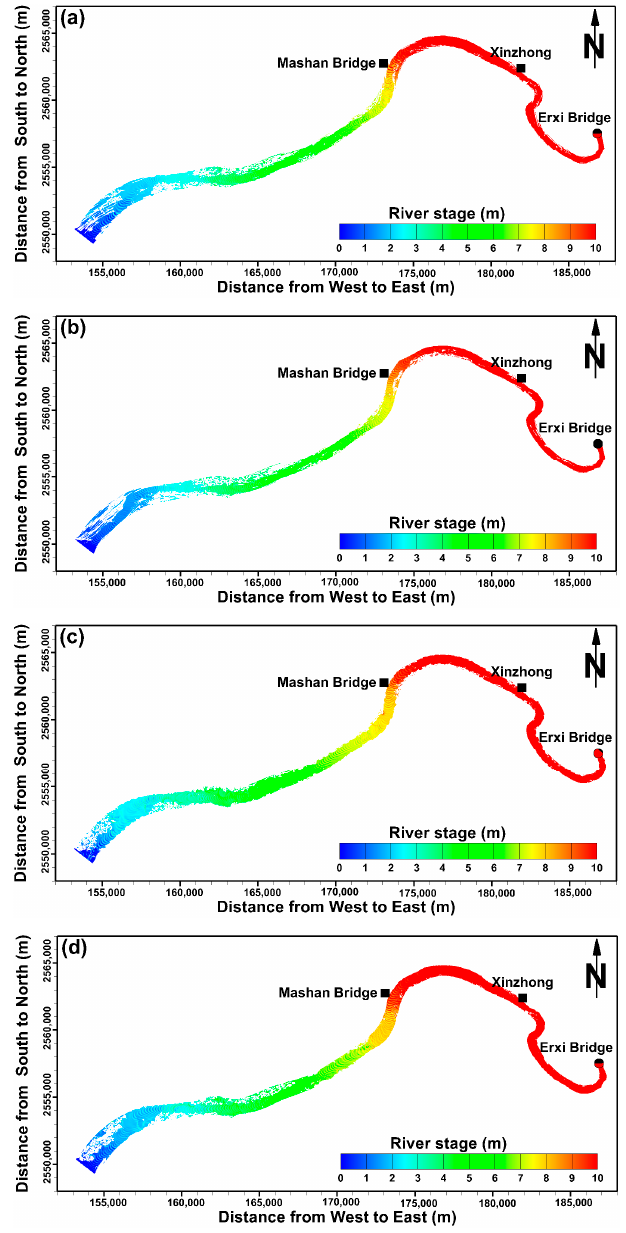
Figure 12. Simulated river stage distributions at 12:00 on 12 June 2012, under the high flow condition using the 2D model with the: ( a ) original cross-section data; and resampled cross-section data according to: ( b ) the linear interpolation method; ( c ) the IDW method; and ( d ) the NN method. Table 1. S tatistical error between the simulated and measured river stages under the low flow condition.